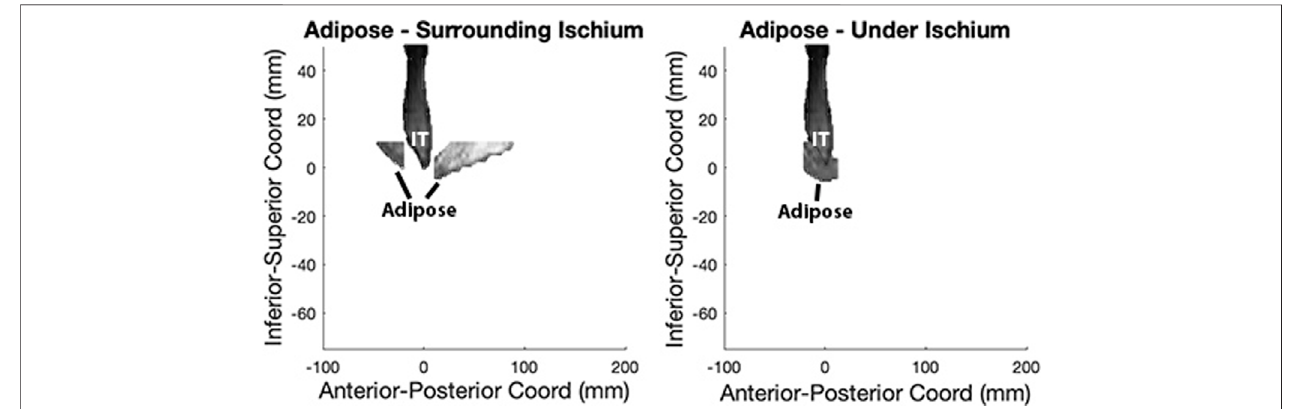
FIGURE 3 | SubQF effect size is calculated using adipose under and surrounding the ischium in the sagittal plane.